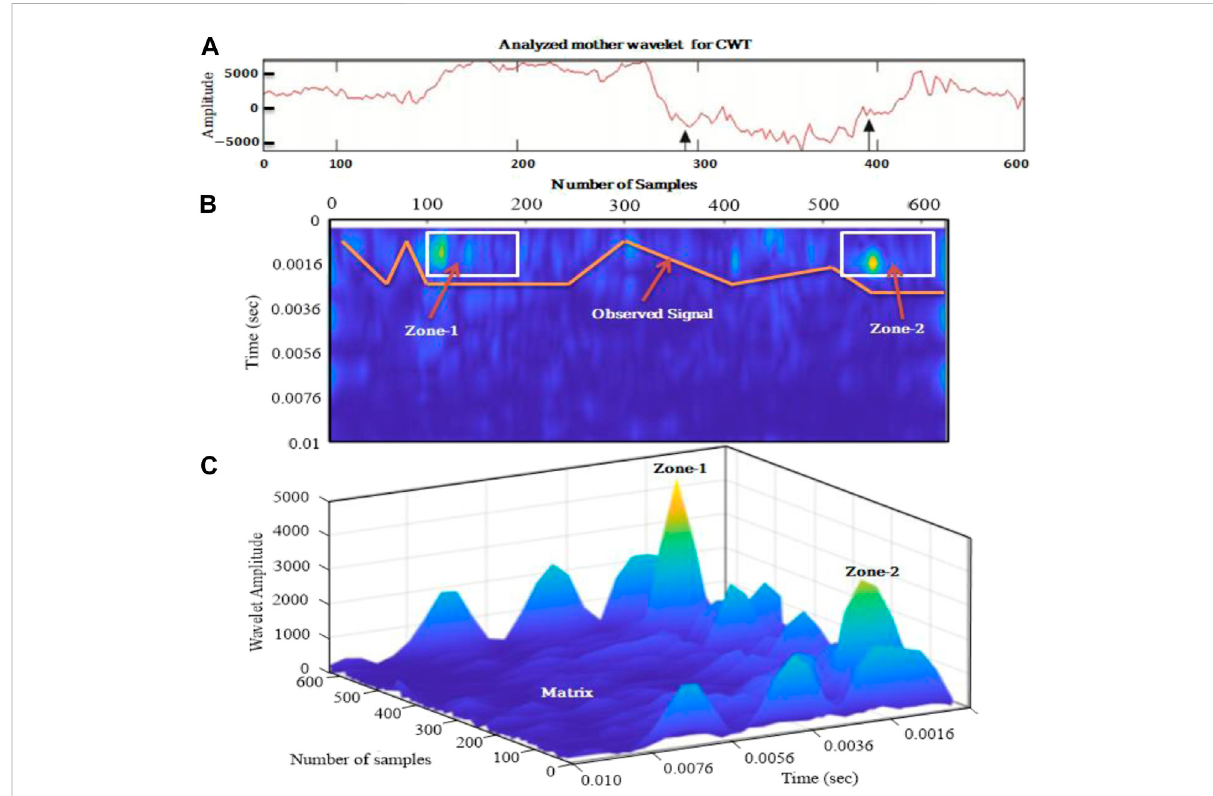
FIGURE 12 Combination of (A) mother wavelet used to analyze GPR data; (B) 2D anomaly detection with observed signal and two anomalous zones marked as zone-1 and zone-2; and (C) 3D visualization of the archeological test site with clear two anomalous zones with color contrast marked as zone-1 and zone-2, same color contrast is an unmarked zone which represents the matrix present in the